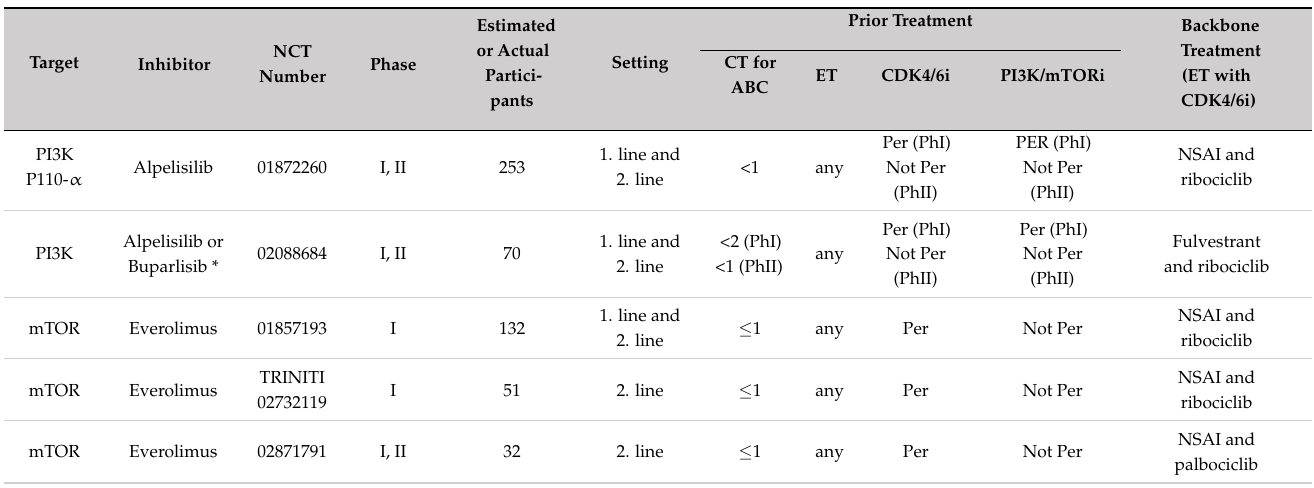
Table 1. Ongoing clinical trials investigating the triple combination with approved CDK4/6, PI3K/mTOR inhibitors, and ET for ER+/HER2 − ABC